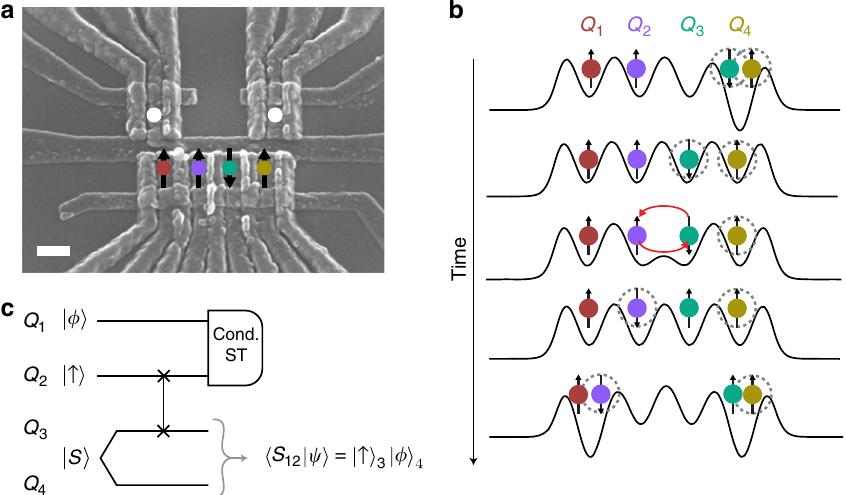
Fig. 1 Experimental setup. a Scanning electron micrograph of the quadruple quantum dot. The positions of the electron-spin qubits are overlaid. The white dots indicate the positions of the sensor quantum dots. The scale bar is 200 nm. b Physical implementation of the teleportation protocol. Dots 3 and 4 are initialized in the singlet con fi guration via electron exchange with the reservoirs and then separated via tunneling. We implement the SWAP gate as a positive voltage pulse to the barrier gate between dots 2 and 3. Pairs of qubits are measured in the singlet/triplet basis via Pauli spin blockade. c Circuit diagram for the conditional quantum teleportation protocol. ψ j i represents the four-qubit